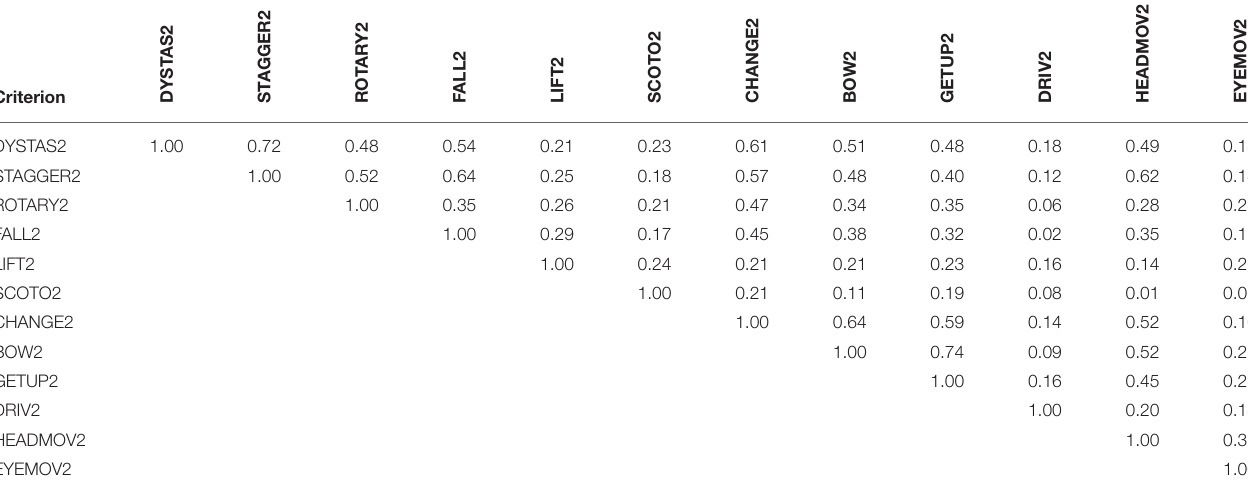
TABLE 2 | Correlation matrix for the 12 single MVS criteria (Pearson product-moment correlations) after 4 weeks of treatment.